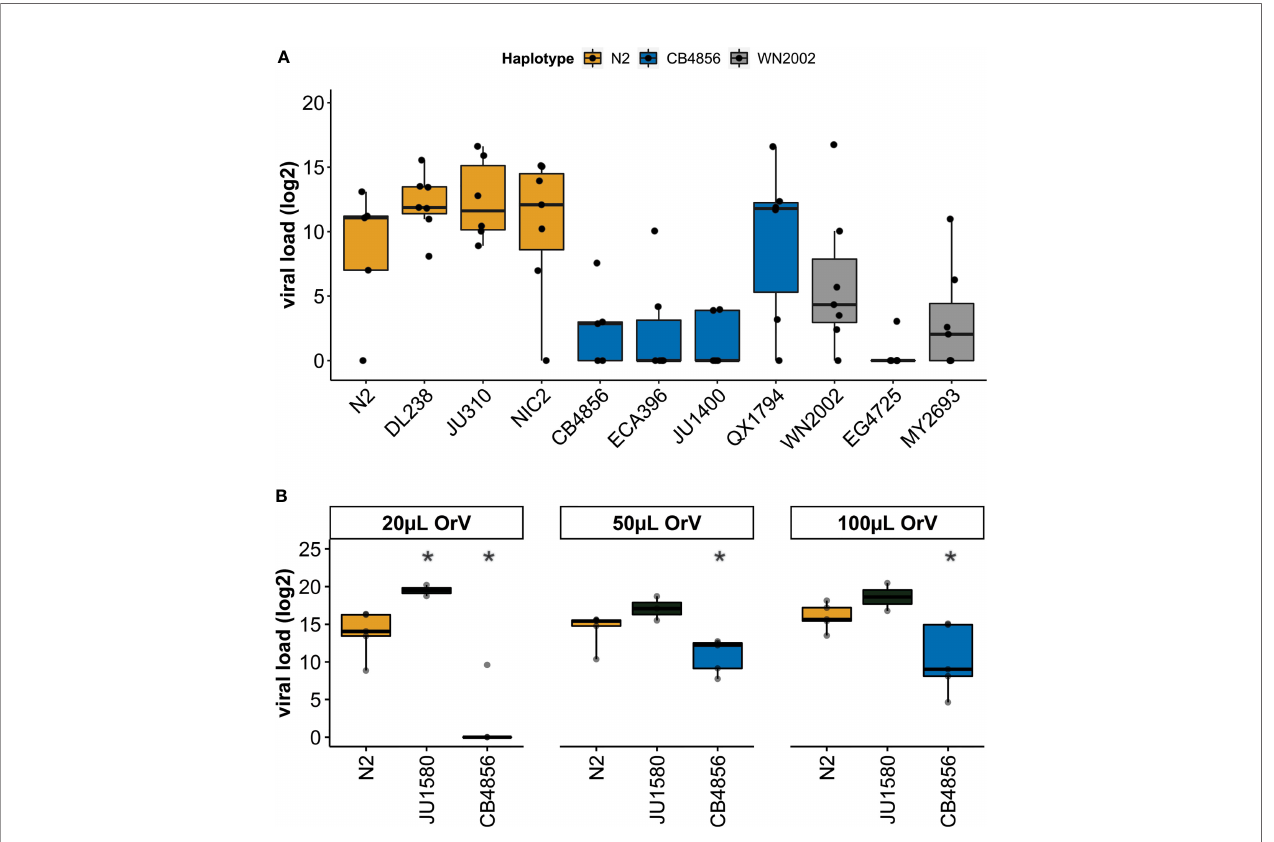
FIGURE 3 | Viral susceptibility of genetically distinct C. elegans strains – (A) Viral loads (log 2 ) as determined by RT-qPCR for three different haplotypes after exposure to 100µL OrV on the plate. The N2 haplotype (N2, DL238, JU310, NIC2 strains) is shown in orange, the CB4856 haplotype (CB4856, ECA396, JU1400, QX1794 strains) is shown in blue and the WN2002 haplotype (WN2002, EG4725 and MY2693) is shown in grey. (B) Viral loads (log 2 ) as determined by RT-qPCR for the strains N2, CB4856 and JU1580 after exposure to 20, 50 or 100µL OrV/500µL infection solution (student t-test; *p <